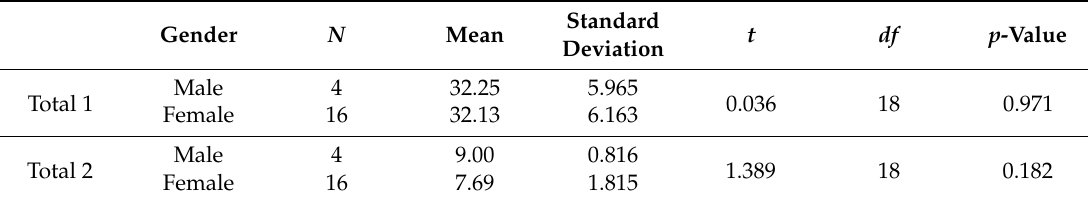
Table 3. t -tests.